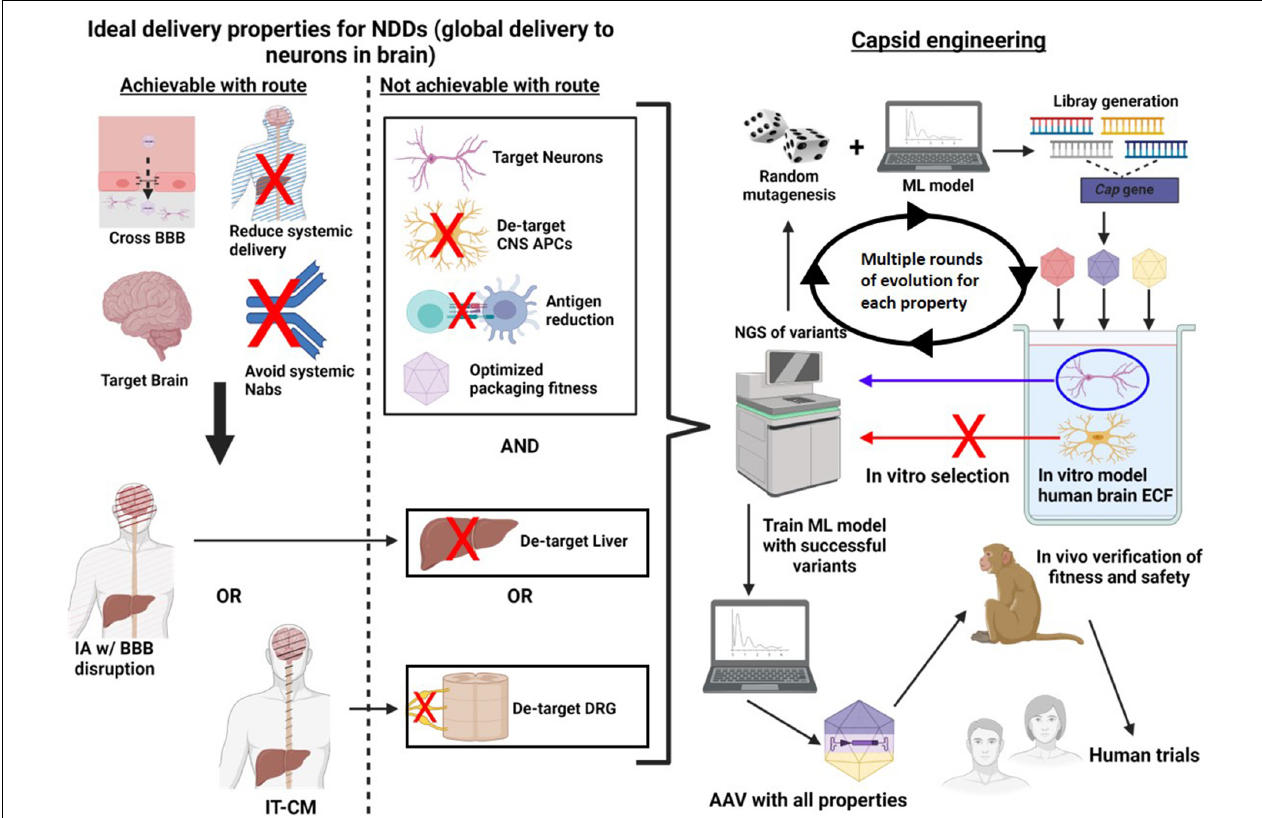
FIGURE 4 | A method of directed evolution to optimize AAV delivery to the brain, in humans. First, properties of an idea delivery system are identified. Next, a delivery route is chosen which optimizes as many of these properties ill and of itself. Capsid engineering can be used to acquire as many of the remaining properties as possible. To do this, random mutagenesis is used and a ML model trained to select only variants with high packaging fitness can be used to diversify the library. Next these variants are introduced into an in vitro model which selects for a desired property, for example a model containing all of the main cell types which the virus could transduce. The DNA is then harvested from the target condition and sequenced using next generation sequencing. In this example variants which transduced neurons are identified for positive selection, while variants which transduced APCs are identified for negative selection. The ML model is then trained with the lists of successful variants. This process is repeated multiple times for a single property until novel high yield variants are no longer discovered in successive rounds of evolution. Once one property is complete, this process can be repeated for new properties using a different in vitro model for selection. Finally, the ML algorithm which has been trained with all of the data can identified variants which have the greatest fitness for all selected properties. These variants are then introduced into NHPs in vivo to confirm that they are function in a live environment and that they are safe. Finally, the variants are ready for human